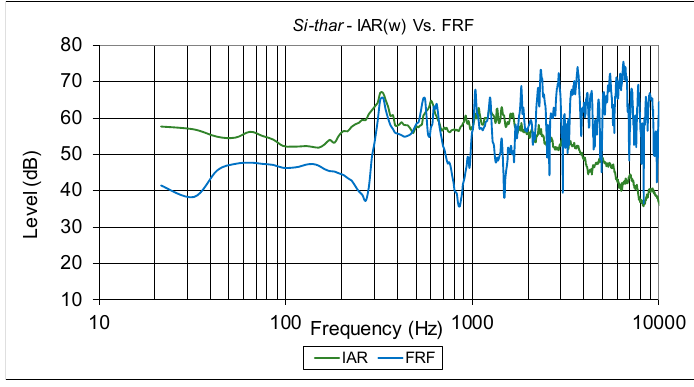
Figure 6. IAR compared with the FRF for the Persian si-thar.